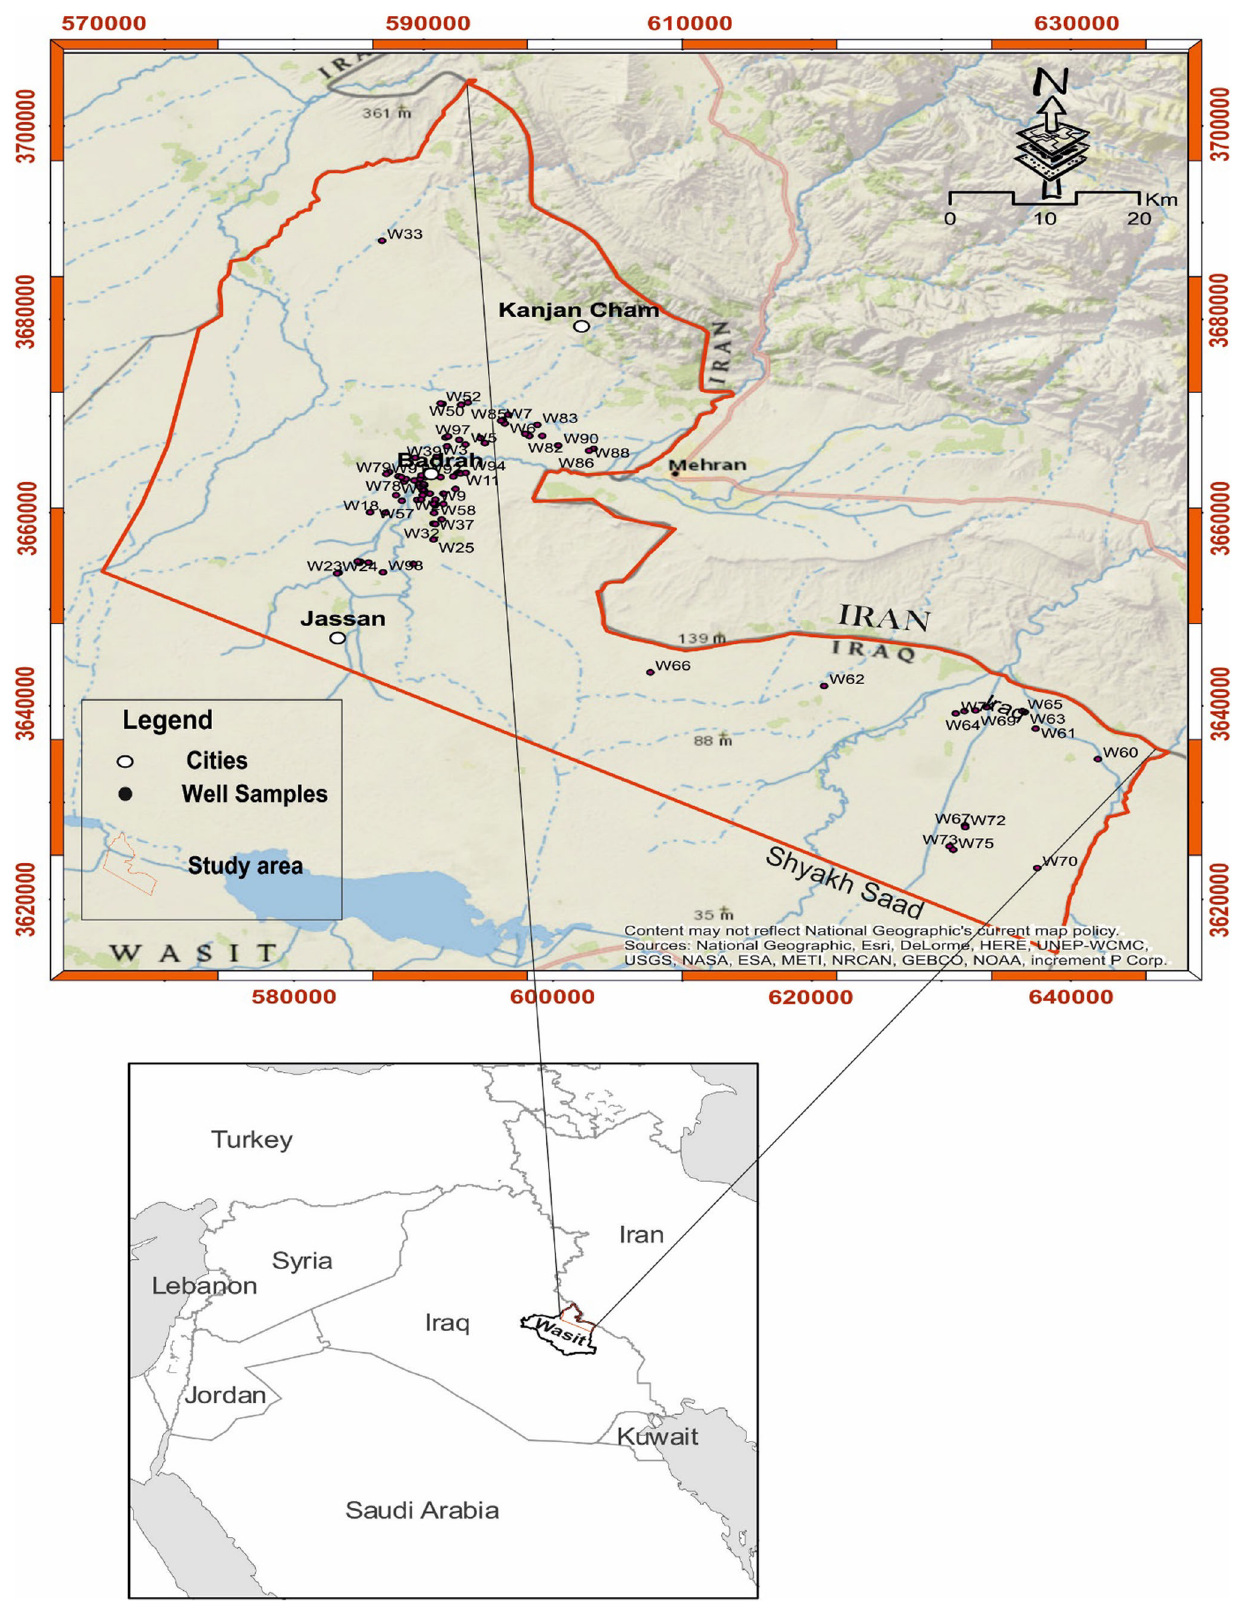
Fig. 1 Location map of the study